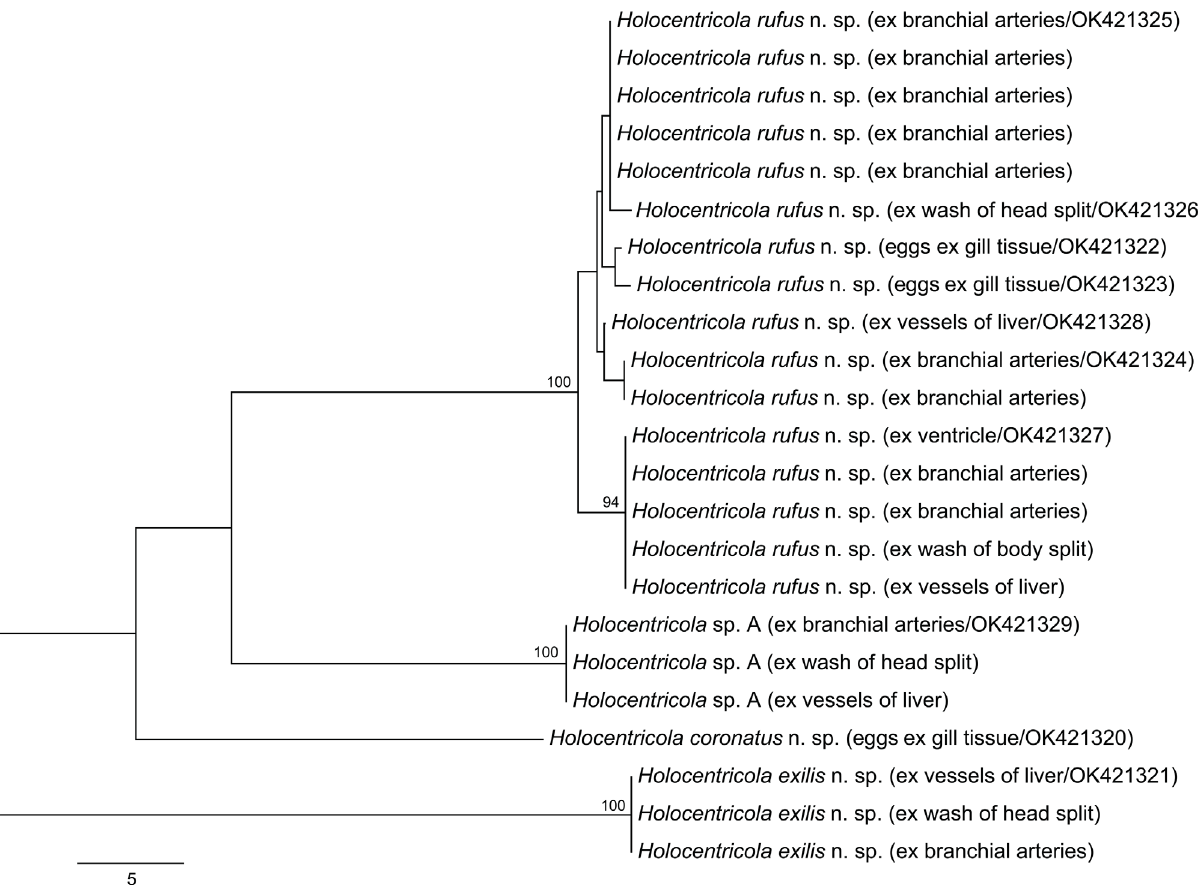
Figure 1. Phylogram from the unrooted Neighbour-joining analysis of the cox 1 mtDNA dataset. Bootstrap support values are shown at the nodes, with values of <85 not shown. The scale-bar indicates the number of base